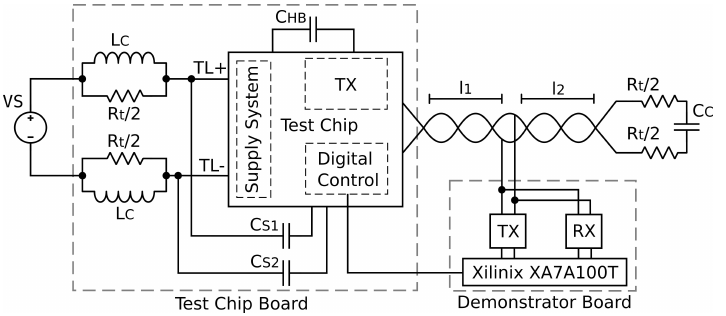
Figure 11. Measurement